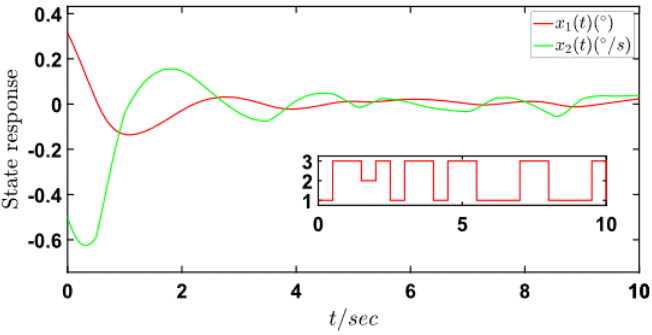
Figure 6. The state response of original system.